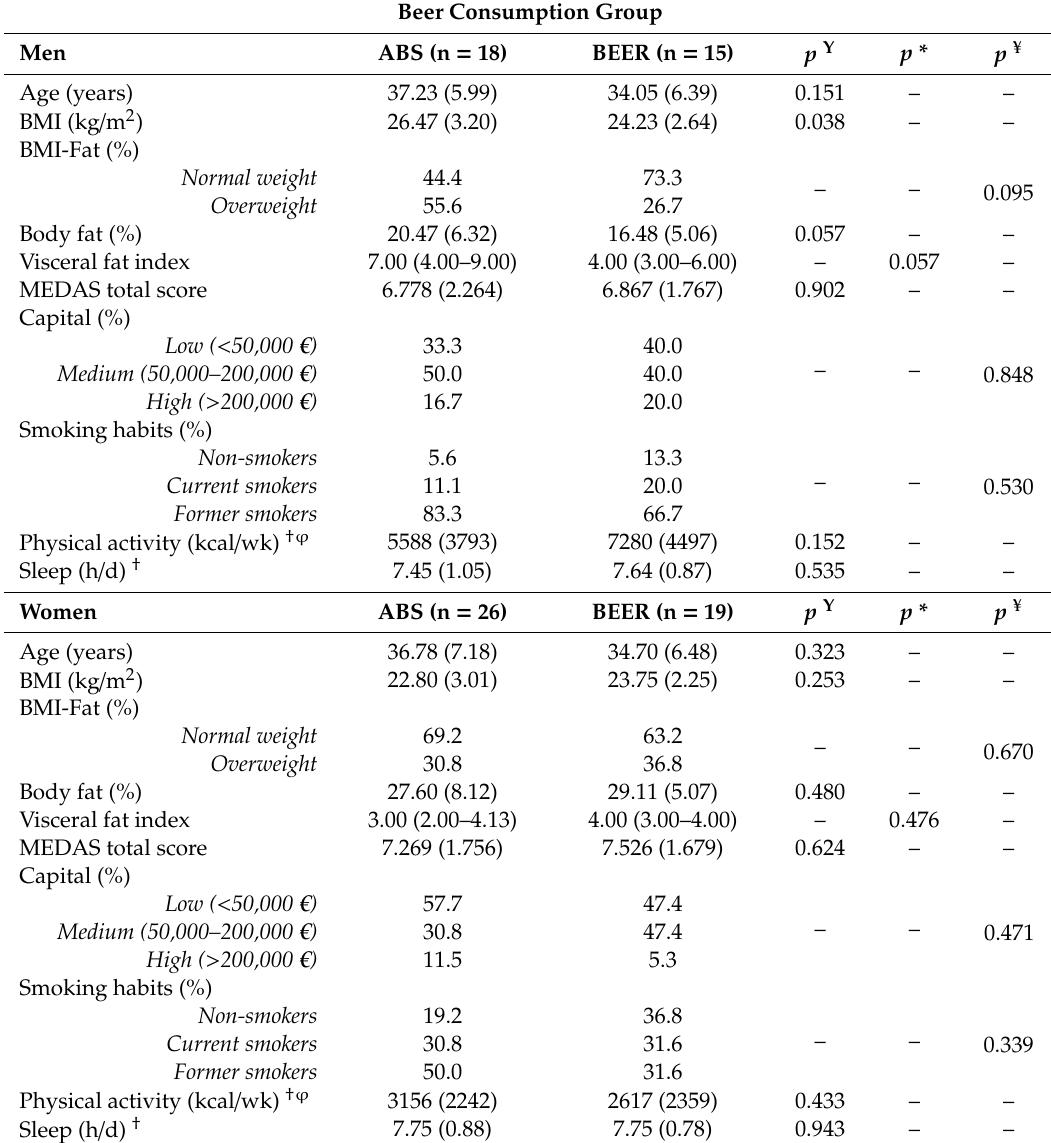
Table 1. Anthropometric characteristics and lifestyle in moderate beer consumers and abstainers (by